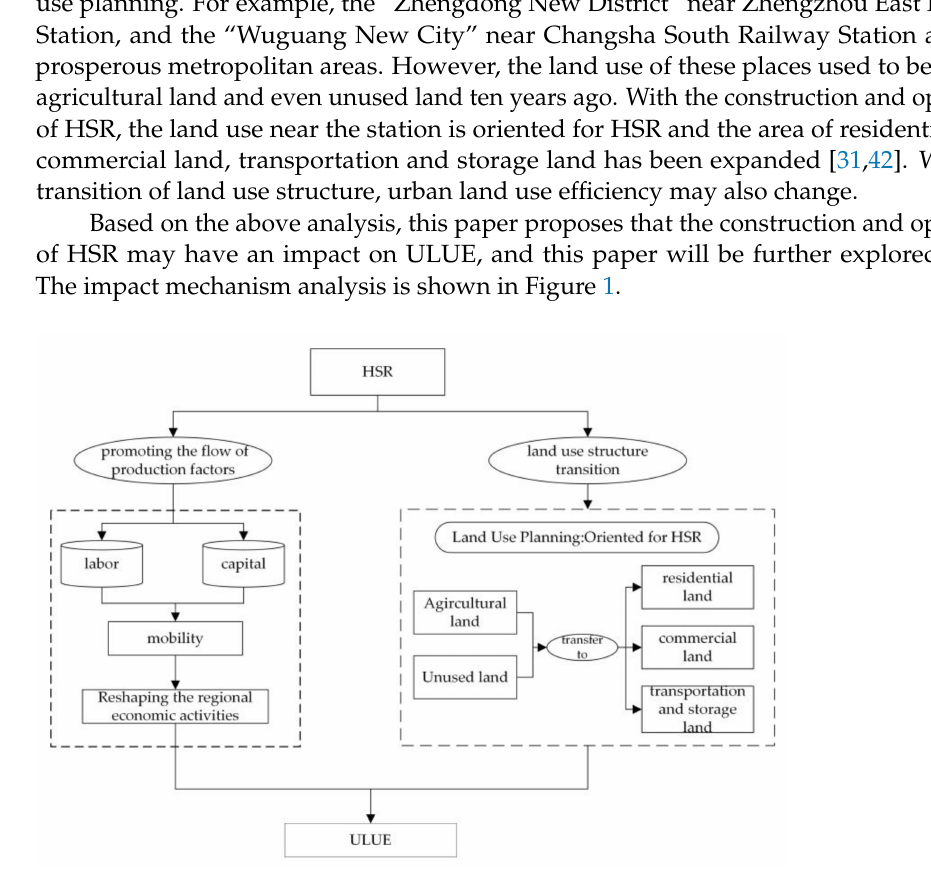
Figure 1. Impact mechanism framework of HSR on